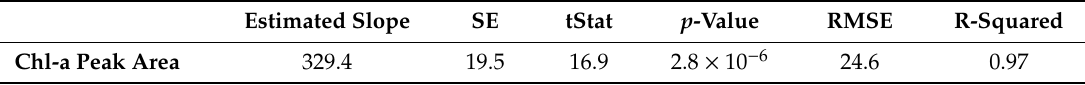
Table 2. Goodness of fit analysis. The linear regression model parameters and relative statistical